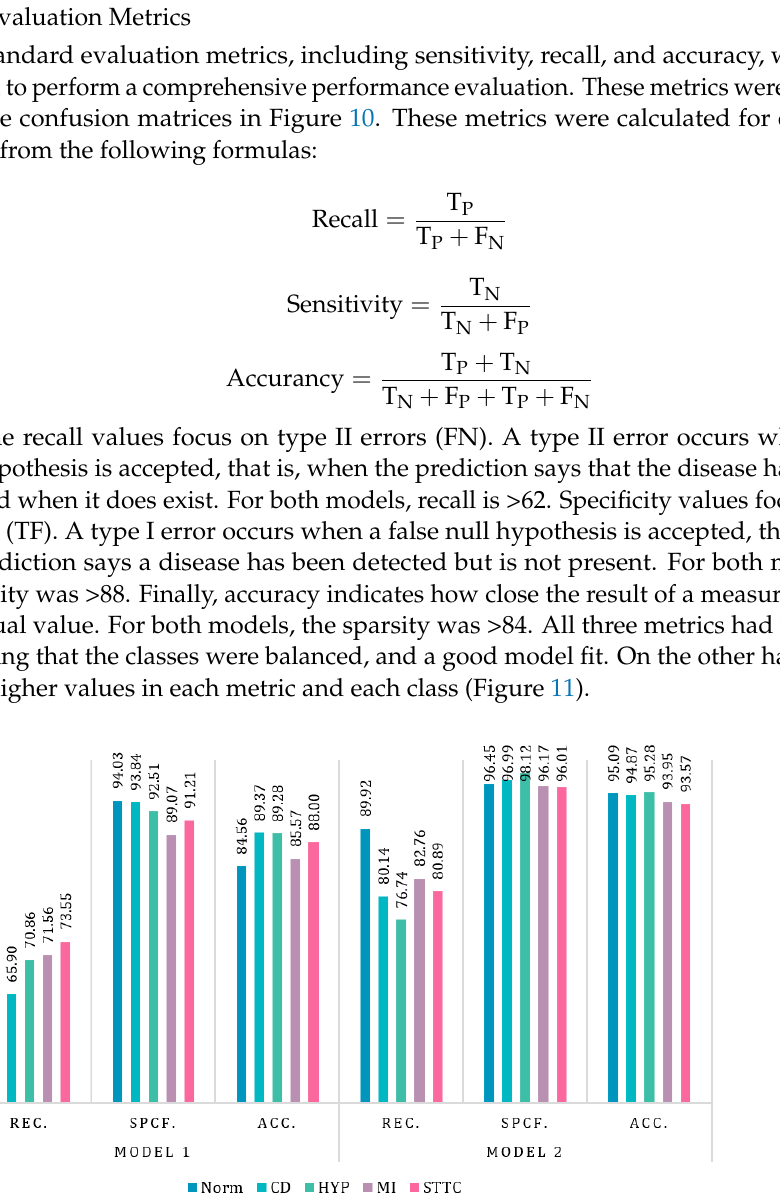
Figure 10. Confusion matrix: ( a ) LSTM model and ( b ) ResNet34 model.